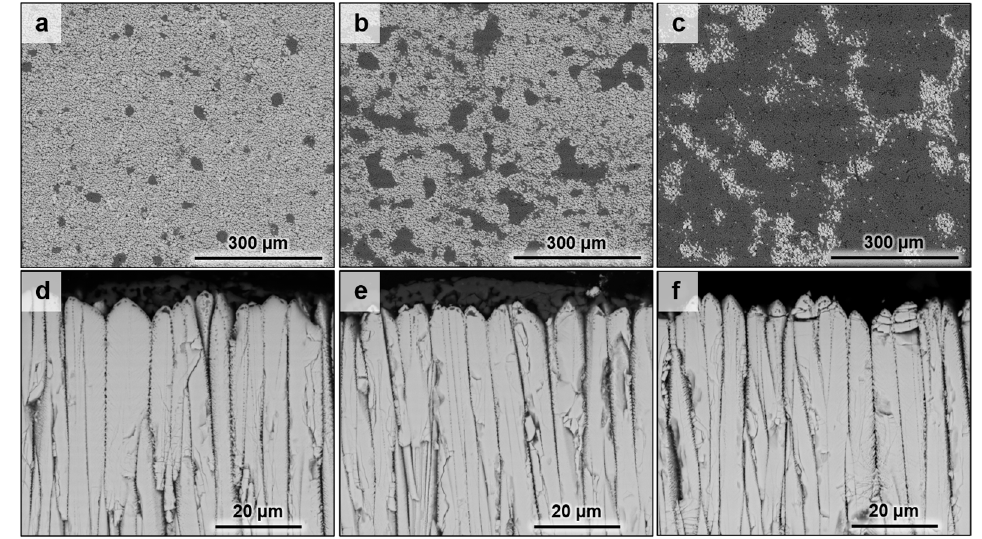
Figure 4. SEM micrographs of the co-stabilised ErYSZ coating with CMAS deposits of ( a , d ) 0.25 mg·cm − 2 , ( b , e ) 1 mg·cm − 2 , and ( c , f ) 5 mg·cm − 2 annealed in air at 1250 °C for 1 h.